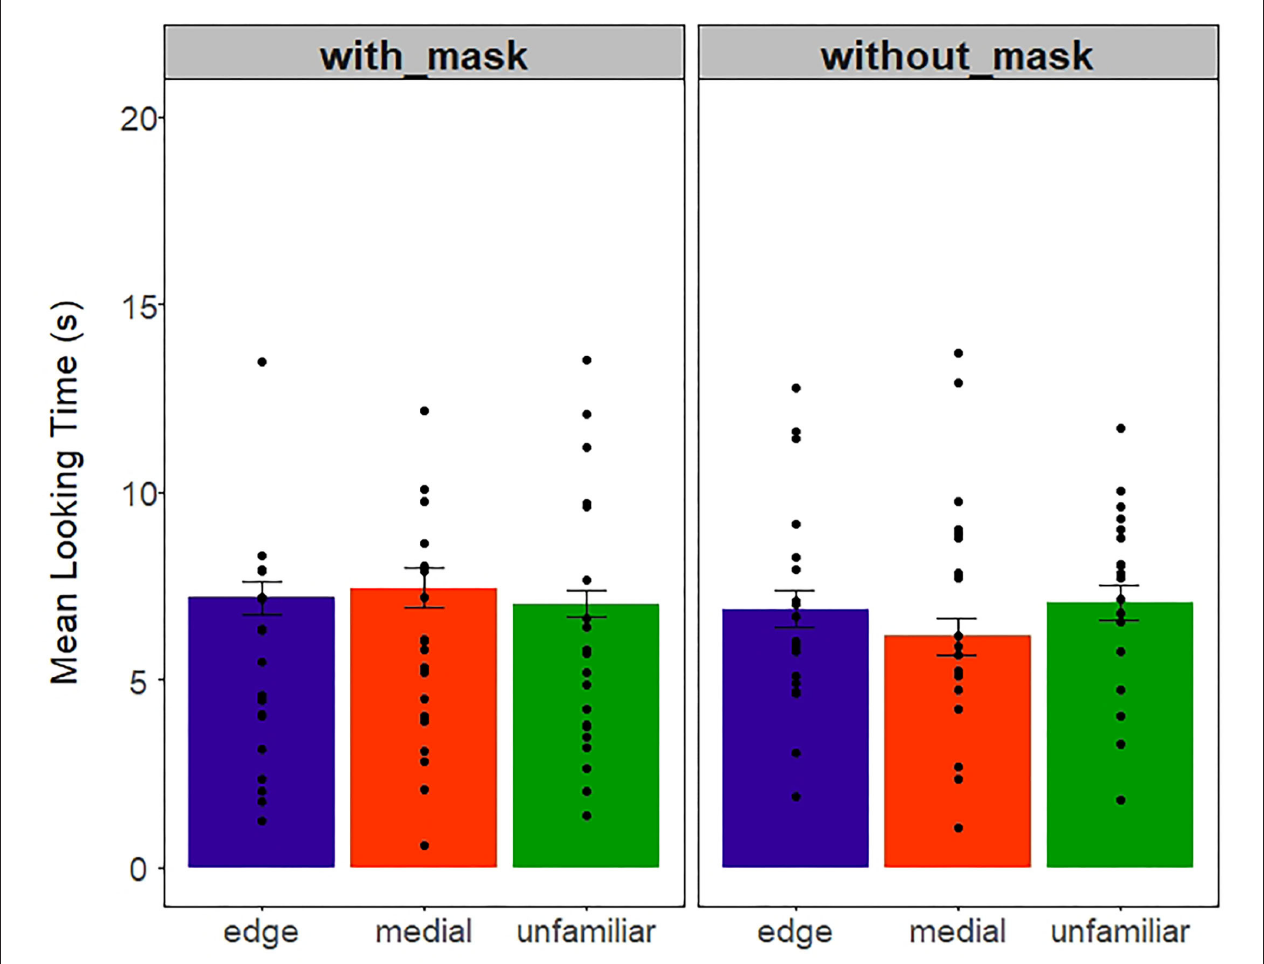
FIGURE 3 | Mean-looking time (s) in the auditory experiment across mask and word-type conditions. Dots represent individual data points. Error bars represent 1 + /– standard error of